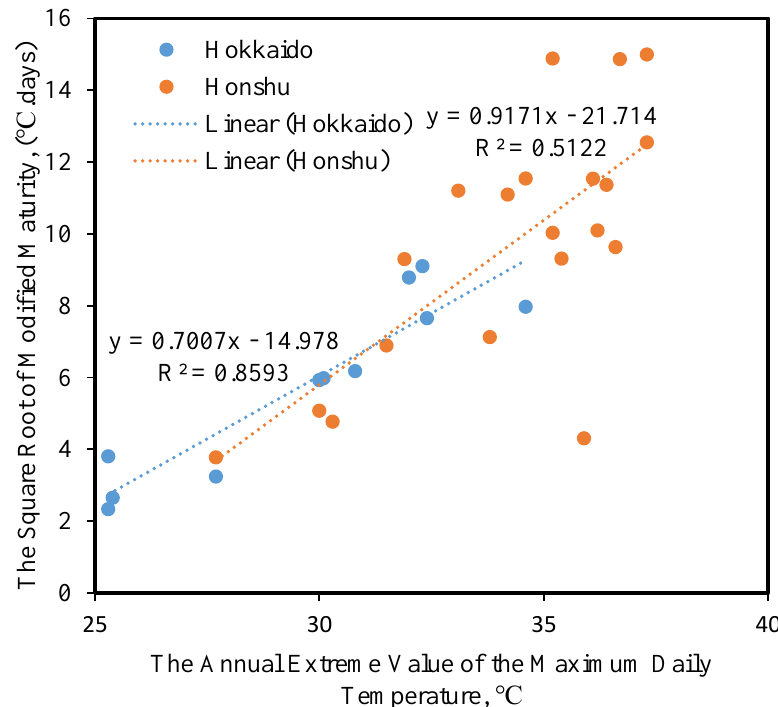
Figure 6. Relationship between the annual extreme value of daily maximum temperature and the modified maturity in each region in Japan.